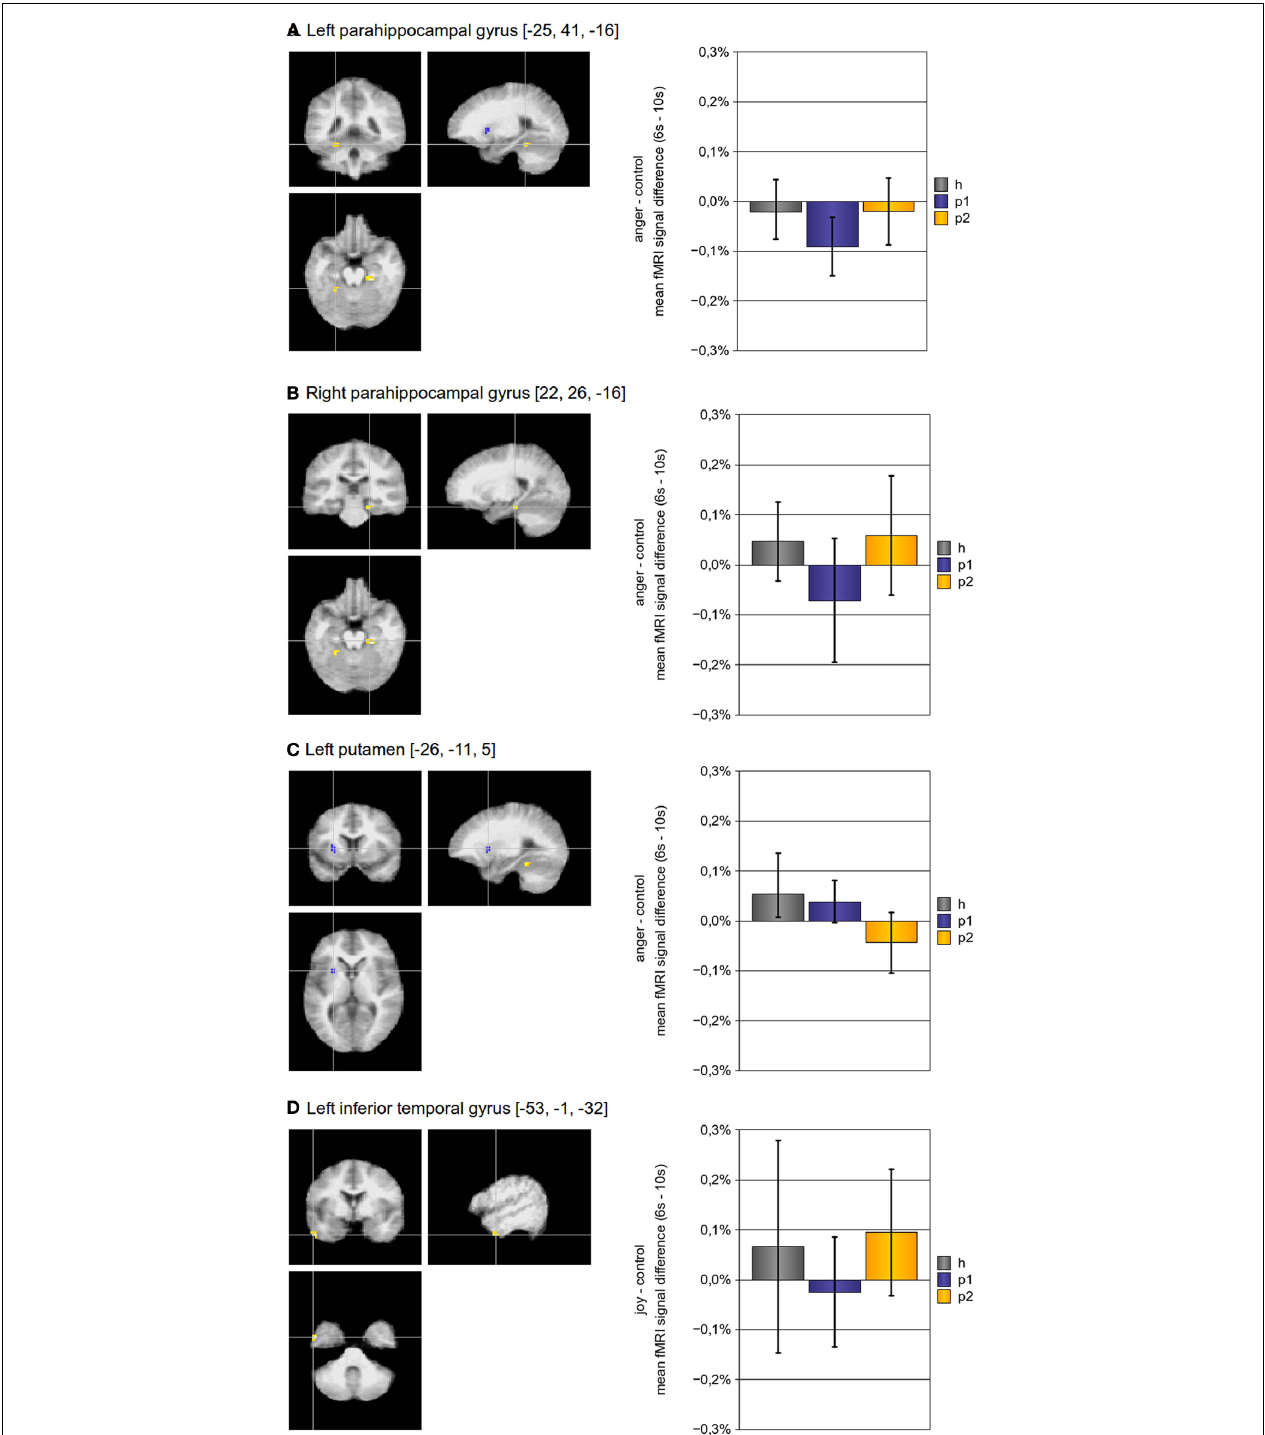
with a cluster size of more than 10 voxels were taken into account. (Abbreviations: h , p 1, and p 2 refer to the mean fMRI signal difference of the according contrast, where h indicates data of healthy subjects, p 1 indicates data of pre-treatment somatoform patients, and p 2 indicates data of post-treatment somatoform patients; error bars indicate the